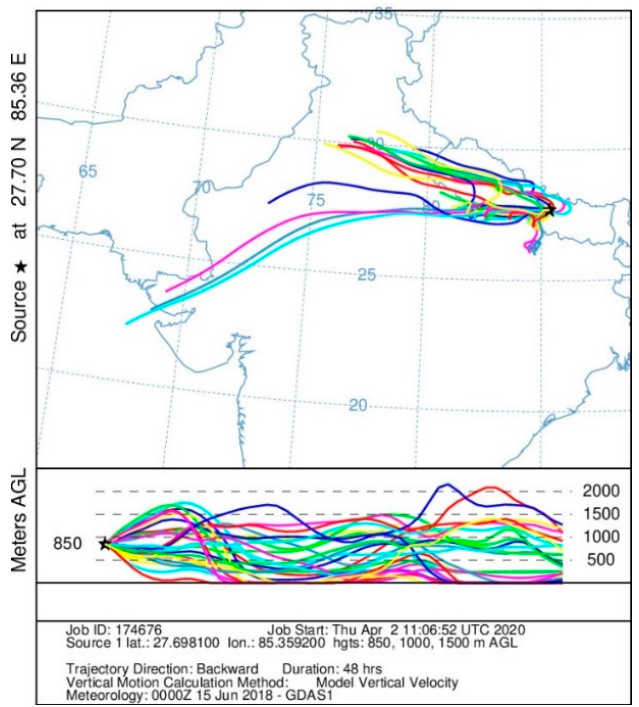
Figure 7. Backward Trajectory by the Hybrid Single Particle Lagrangian Integrated Trajectory (HYSPLIT) model [31] ending at 2300 UTC on 15 June 2018.